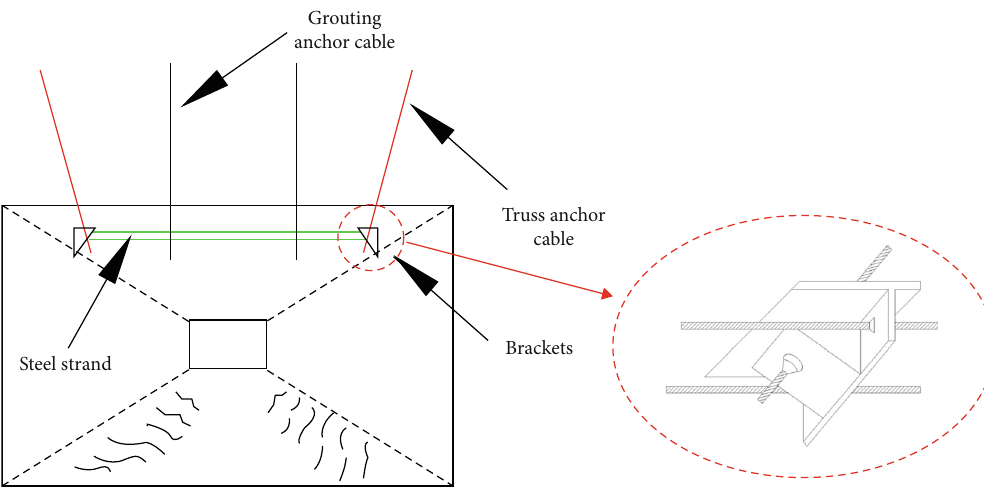
Figure 16: Schematic diagram of high-strength pretightening steel strand